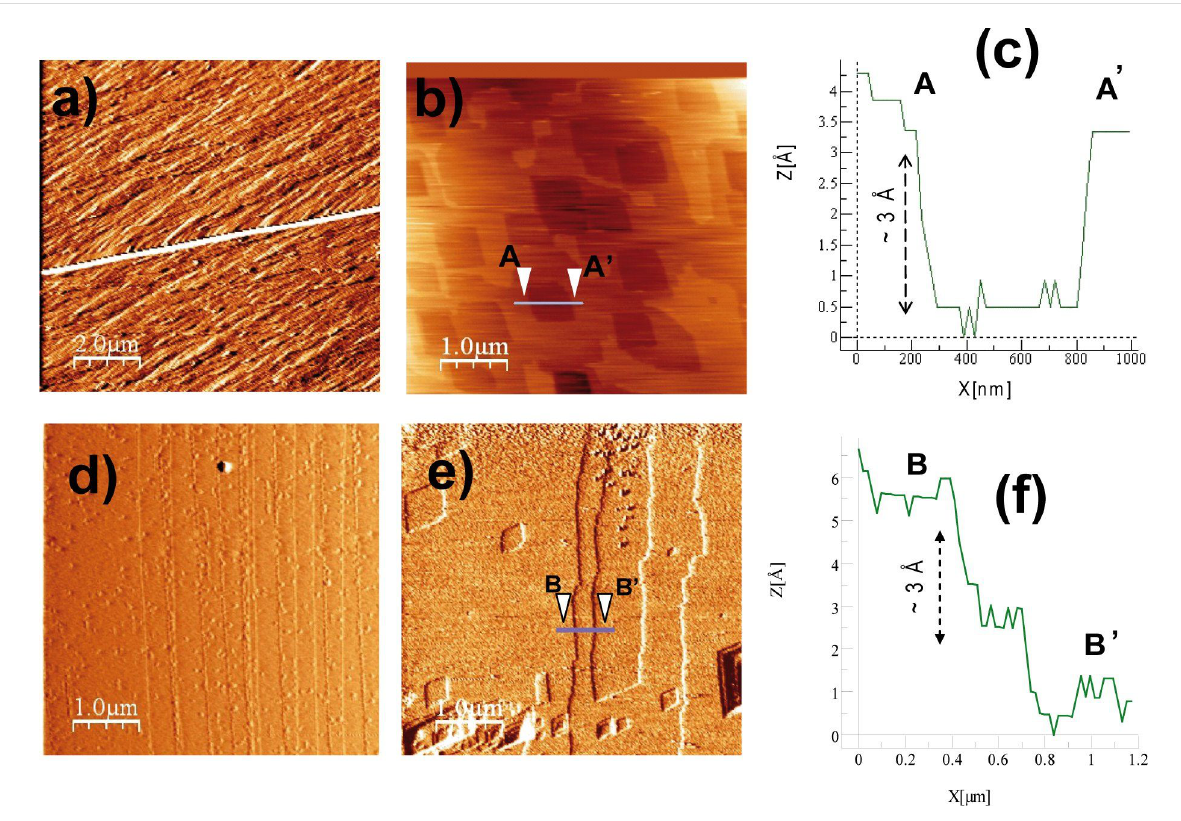
Figure 1: AFM deflection images of calcite cleavage surfaces. Top row: a) image in air shows the initial flat surface with a topographic variation that ranges over 2 nm. The white line across the image corresponds to a terrace; b) same surface region with some drift after 300 s in Millipore MQ water showing a high density of etch pits homogeneously distributed and c) depth profile of an etch pit section. Bottom row: d) image in air shows the initial flat surface with a topographic variation that ranges over 4 nm and e) same surface region after 240 s in Millipore MQ water showing the random for- mation of etch pits and f) depth profile of a step edge section shown by the arrows in